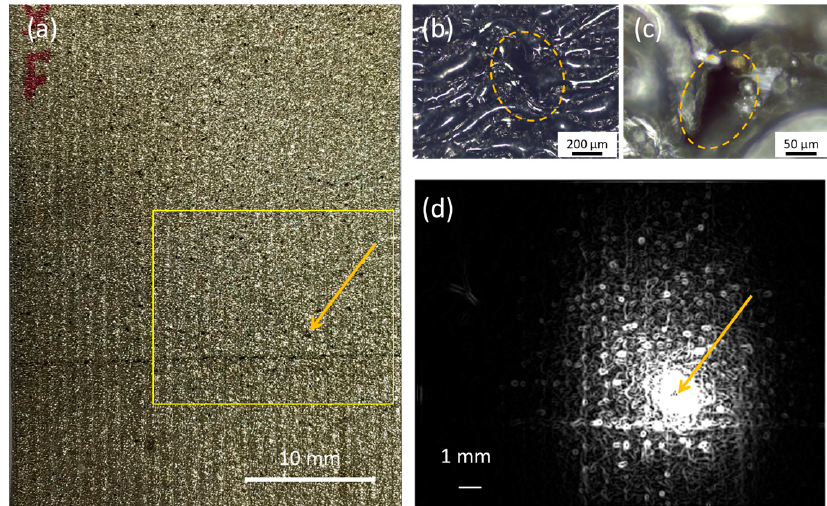
Figure 3. ( a ) A photo of a porous metal sample A with pores and cracks. The LLT inspection area is indicated as a yellow rectangle. An arrow indicates the location of a hole. ( b , c ) Zoom-in microscope images of the hole. ( d ) An amplitude image of single-spot LLT measurement at f = 0.0248 Hz.